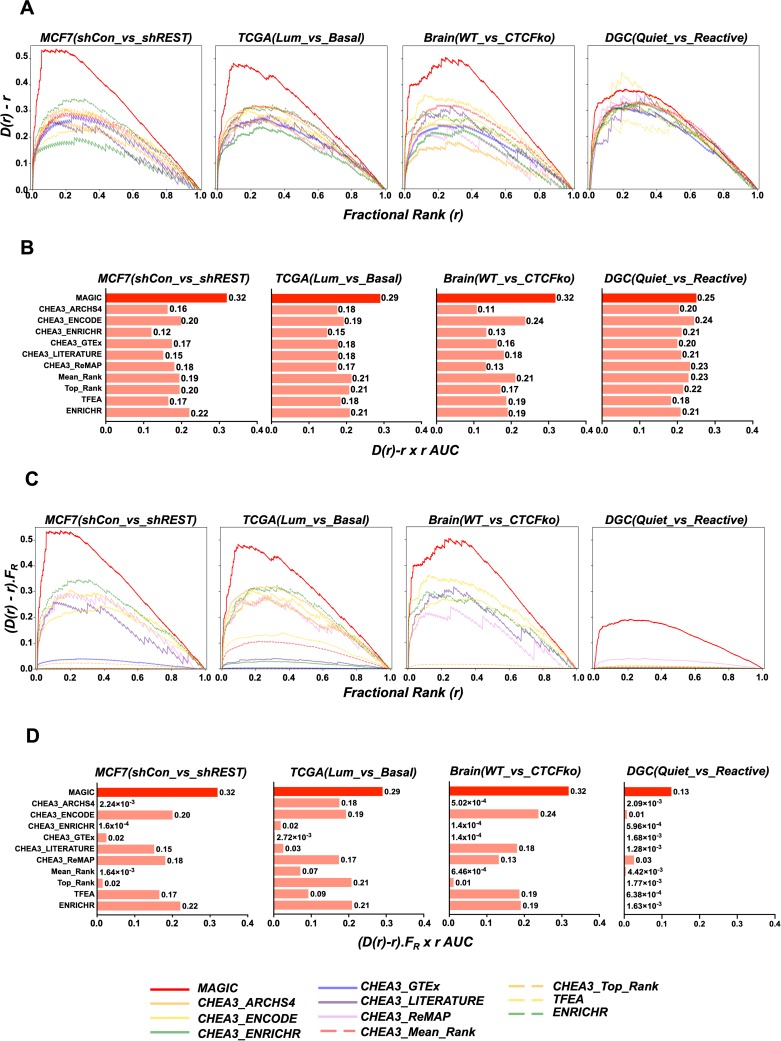
Manipulated transcription factors and associated cofactors are preferentially ranked by MAGIC compared to CHEA3, TFEA and Enrichr.(A) Emperical cumulatives were generated of factional ranks (1/Integer ranks) for manipulated factors and associated cofactors for the 4 datasets using all algorithms and libraries as in Fig 1. The difference between the cumulative of all scaled fractional ranks and a uniform distribution for the manipulated factor and associated cofactors is plotted against the fractional rank. Kolmogorov-smirnov tests of each distribution against a uniform distribution yields p<10−10 for all tests. (B) Area Under Curve (AUC) for D(r)-r x r curves in panel A. (C) The D(r)-r curves in panel A were scaled for the rank of the manipulated actor. For each algorithm, D(r)-r was multiplied by the fractional rank of the manipulated factor (FR). (D) AUCs for curves in panel C.